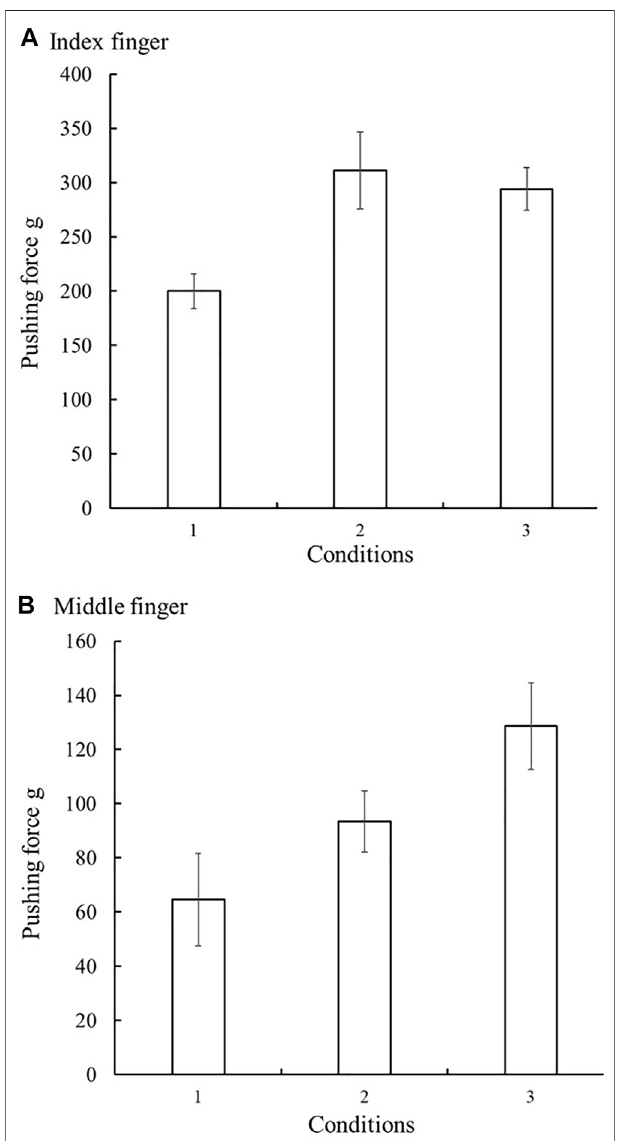
FIGURE 7 | Example ofthe pushing force measured by the force sensor in each EMS condition for one subject. The pushing motion was controlled by only EMS. (A) shows the pushing force of the index fi nger, and (B) shows the pushing force of the middle fi nger. EMS was performed by adding a current of 20 mA for condition 1, 30 mA for condition 2, and 40 mA for condition 3.